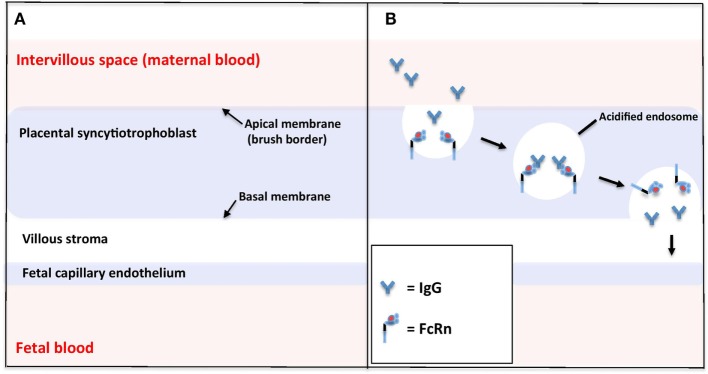
Schematic of the microstructure of the human placental barrier at term (A) and the neonatal Fc receptor (FcRn)-mediated endocytosis of immunoglobulin G (IgG) across the placental syncytiotrophoblast (B).